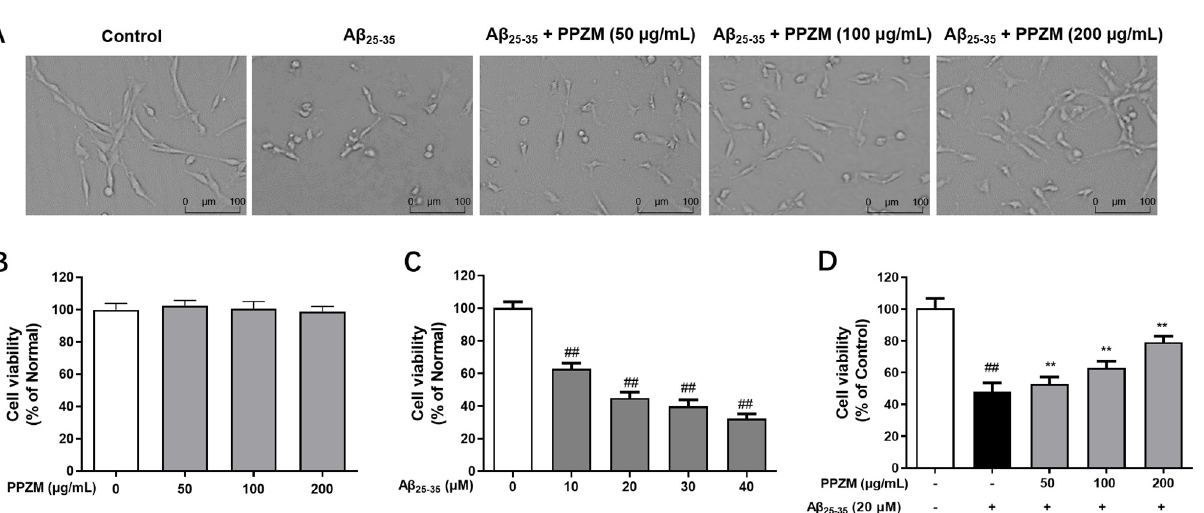
PPZM (50, 100, and 200 µ g/mL) gradually relieved the apoptosis of the A β 25–25 treated cells in a concentration-dependent manner.